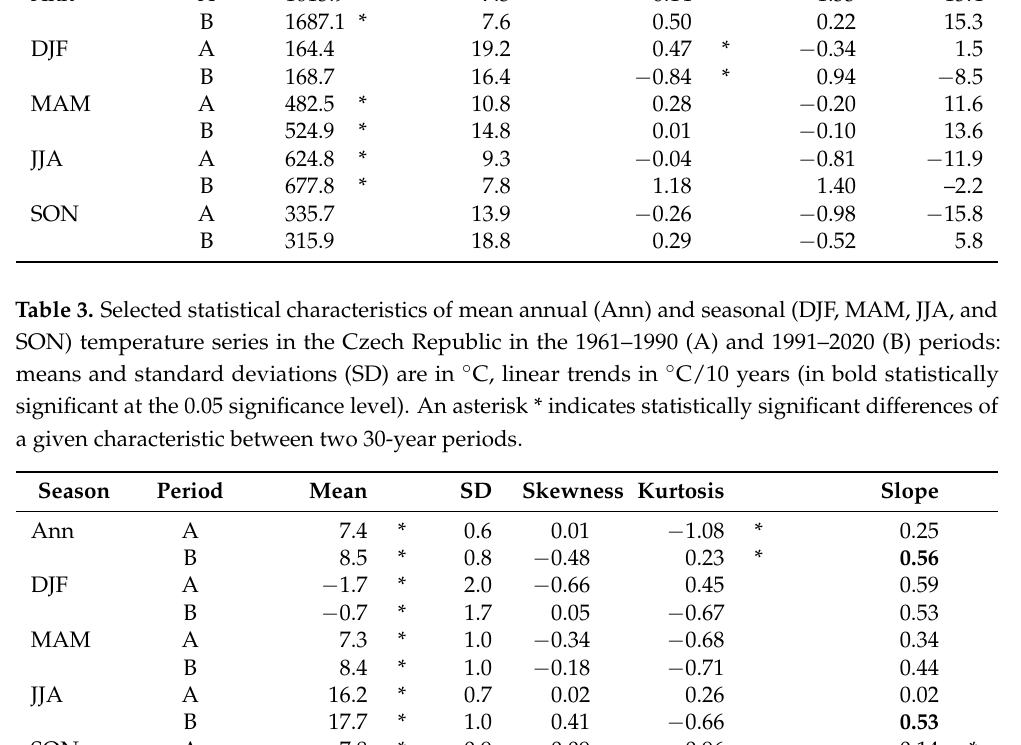
Table 2. Selected statistical characteristics of mean annual (Ann) and seasonal (DJF, MAM, JJA, and SON) sunshine duration series in the Czech Republic during the 1961–1990 (A) and 1991–2020 (B) periods: means are in hours, coefficients of variation (CV) in %, linear trends in hours/10 years (none statistically significant at the 0.05 significance level). An asterisk * indicates statistically significant differences of a given characteristic between two 30-year periods. Season Period Mean CV Skewness Kurtosis